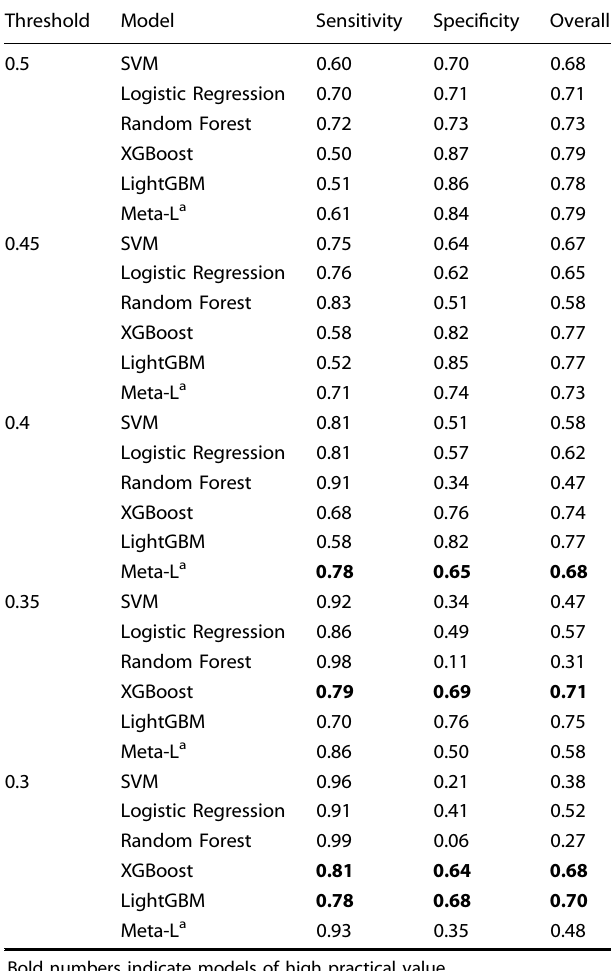
Table 1. ML models applied to the CLIMB dataset with varying